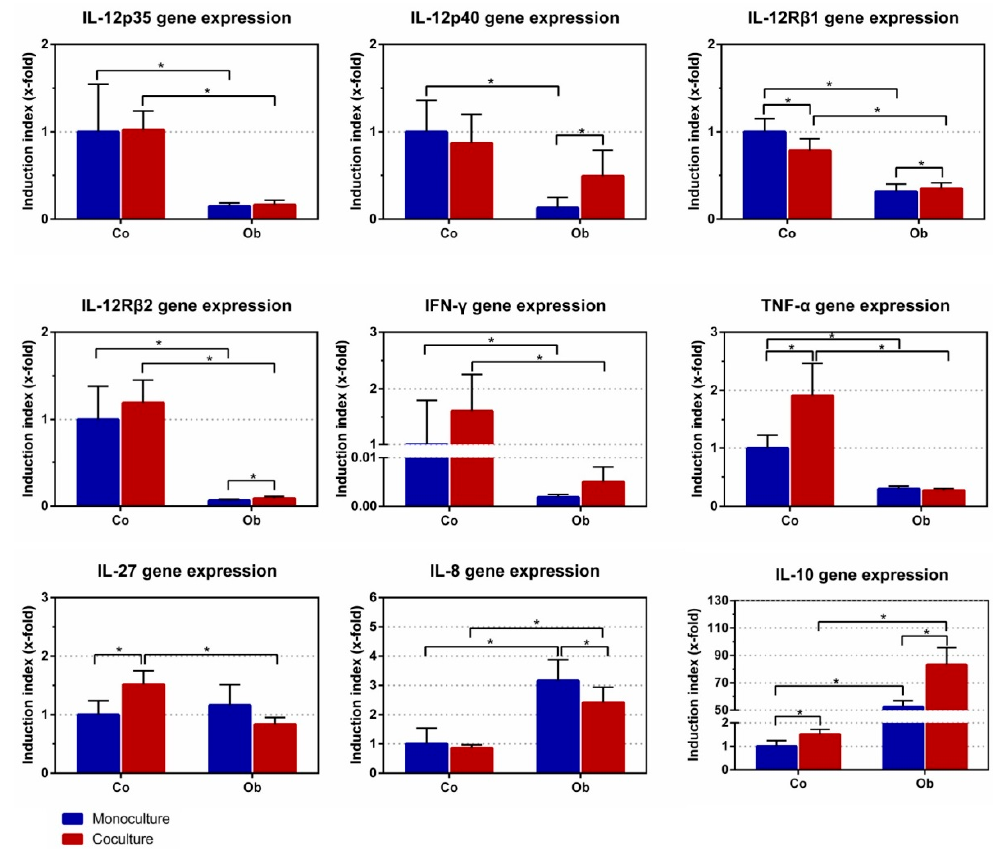
Figure 6. Quantitative gene expression in DCs (day 7 of differentiation) cultivated as monocultures or co-cultures with undifferentiated (co) and osteogenically induced JPCs for 21 days (ob). IL-12p35, IL-12p40, IL-12Rß1, IL-12Rß2, IFN- γ , TNF-a, IL-27, IL-8, and IL-10 gene expressions were quantified by the Light Cycler system, and ratios of listed genes in relation to the housekeeping gene GAPDH were calculated. Gene levels in DC monocultures (with control (co) medium) were set as 1, and induction indices (x-fold) in relation to this control were calculated. Results were averaged from 6 independent experiments.